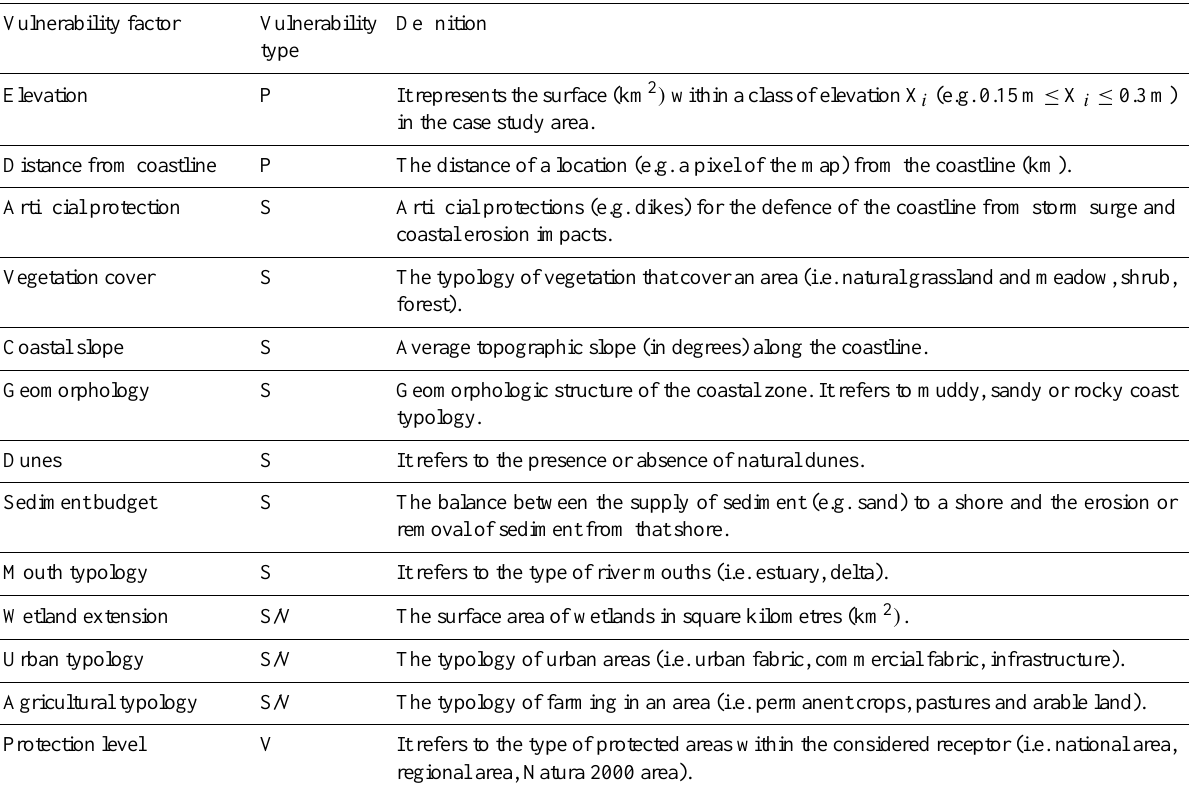
Table 2. Vulnerability factors used for the assessment of coastal vulnerability to climate change at the regional scale in the coastal area of the North Adriatic Sea. Vulnerability factors are categorized into pathway factors (P), susceptibility factors (S), and value factors (V).